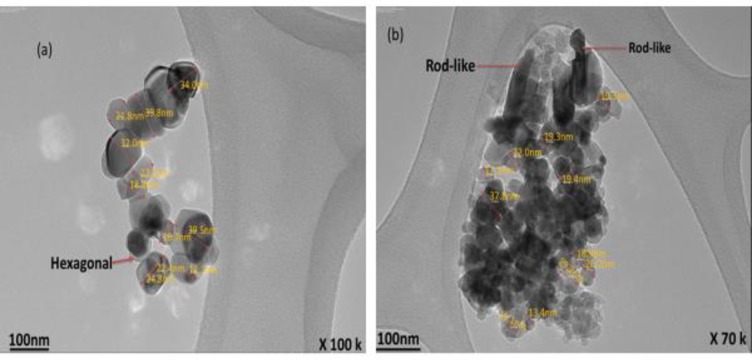
TEM image of CNP.